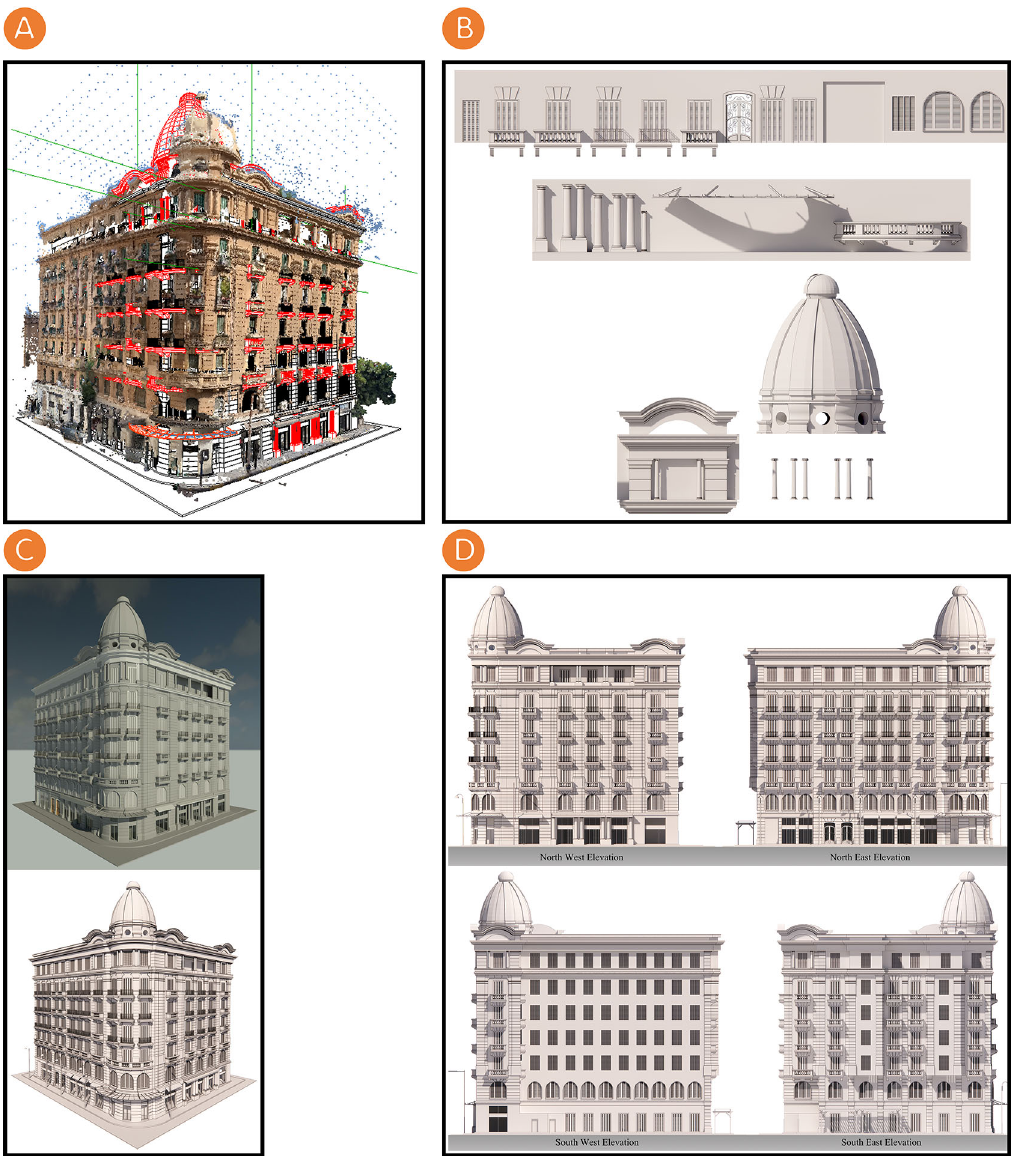
Figure 4. (A) Importing 3D textured and coloured triangle mesh on Autodesk Revit platform for the docu- mentation and modelling of Société Immobilière building; (B) Creating a RFA, which is a unique library of BIM parametric objects created by the researchers on Autodesk Revit platform used on documentation and modelling of Société Immobilière building; (C) Top - Rendering the Société Immobilière building on Autodesk Revit platform, Bottom - Rendering the Société Immobilière building on Enscape3D platform; (D) Top - North- west and north-east elevations of the Société Immobilière building rendered by using Enscape3D platform, Bottom - South-west and south-east elevations of the Société Immobilière building rendered by using Enscape3D platform. The photos (A), (B), (C), and (D) were acquired from the researchers ’ working on the